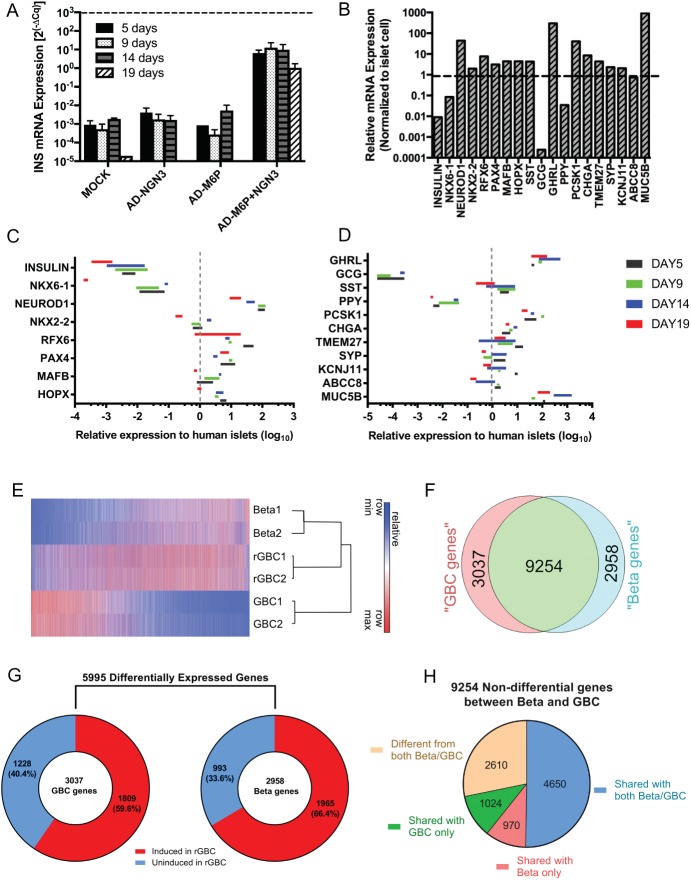
Expression of islet-associated genes in transduced GBCs.(A) Insulin mRNA level expression in GBCs after adenoviral transduction with NEUROG3 (NGN3), MAFA (M), PAX6 (6), PDX1 (P) as measured by RT-qPCR. The dashed line denotes insulin mRNA level in human pancreatic islets. (B) Expression levels of pancreatic genes on day 14 in rGBCs as measured by RT-qPCR. MUC5B served as a GBC marker. (C-D) M6PN-transduced GBCs were harvested on days 5, 9, 14 and 19 post-transduction. Gene expression levels of pancreatic endocrine factors were measured by RT-qPCR. Relative expression levels were calculated using the formula: [2^(-ΔCq rGBC)]/[2^(-ΔCq human islet)]. The dashed line marks the point where gene expression level is equivalent to human islets. (E) Heat map from clustering of differentially expressed genes in rGBCs in comparison to GBCs and human β cells as determined by RNA-sequencing. (F) Venn diagram depicting non-differential genes (light green) and differentially expressed genes upregulated in GBC ("GBC genes") and β cells ("Beta genes"). (G) Break-down of the frequencies of "GBC genes" and "Beta genes" into induced or uninduced genes in rGBC. (H) Pie chart distribution of the 9254 non-differentially expressed genes in both unreprogrammed GBC and β cells into 4 groups based on global gene expression profile in rGBC.